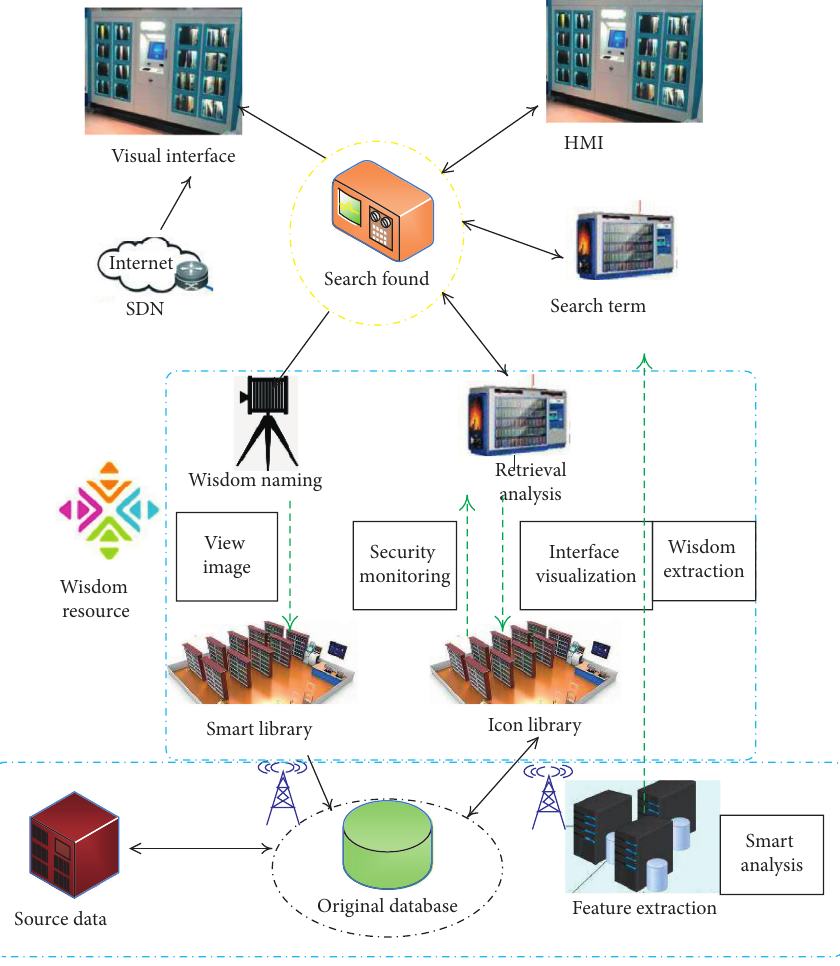
Figure 7: Information visualization model of smart